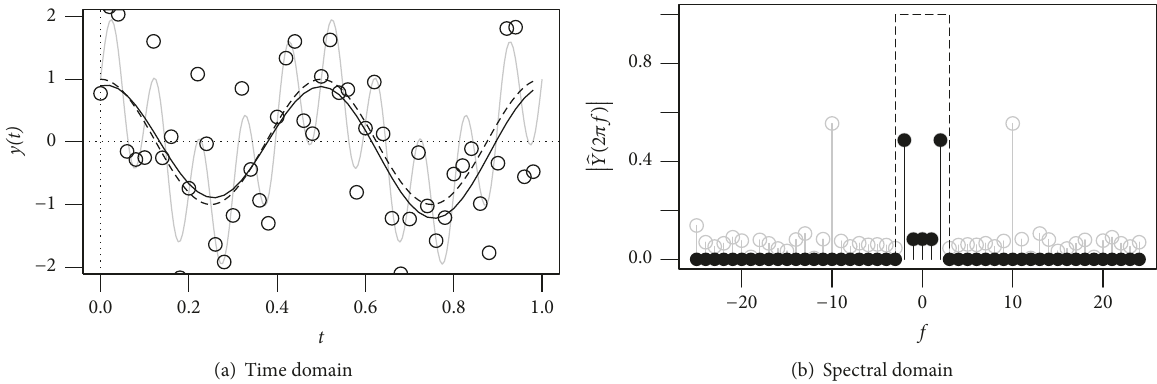
Figure 11: Calculating the ideal low pass filter. Panel (a) shows the original function (gray line) and the noisy sampling points (open symbols). The result of the ideal low pass filter in the time domain is given in (a) by the solid line. The dashed line in (a) illustrates the low frequency part of the signal with 𝑓 = 2 . Panel (b) displays the spectrum of the original function (gray), the filtered result (black), and the spectral kernel function